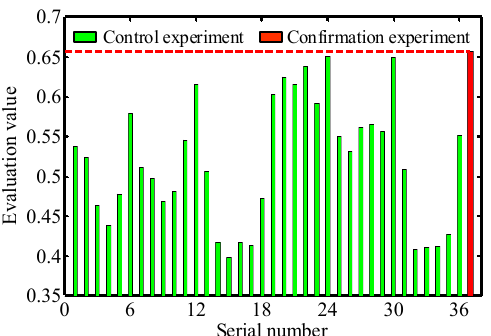
Figure 16. Comprehensive evaluation value of control experiments and confirmation experiment.